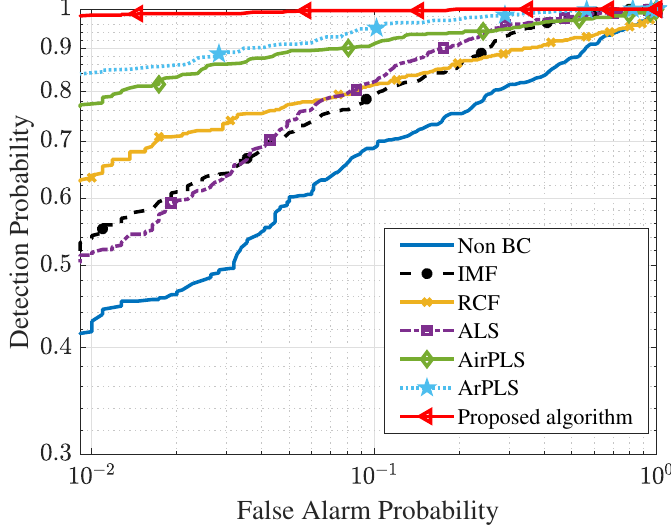
Figure 5. ROC curves of the ASD for the GF